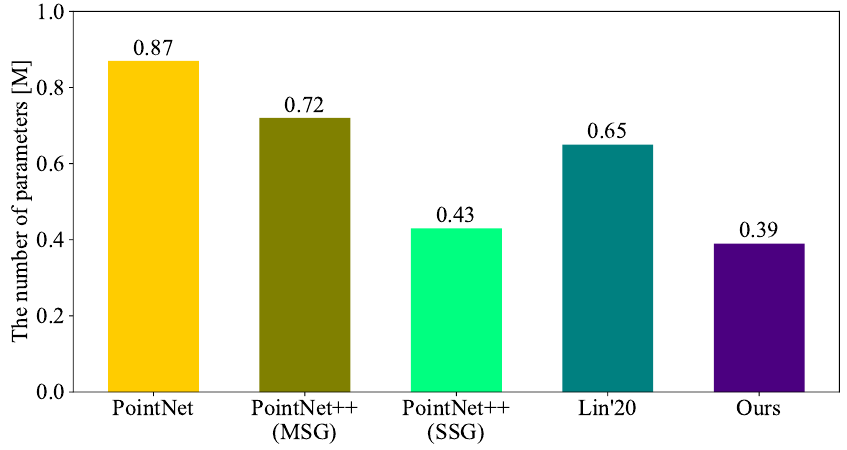
Figure 8. Evaluating the number of